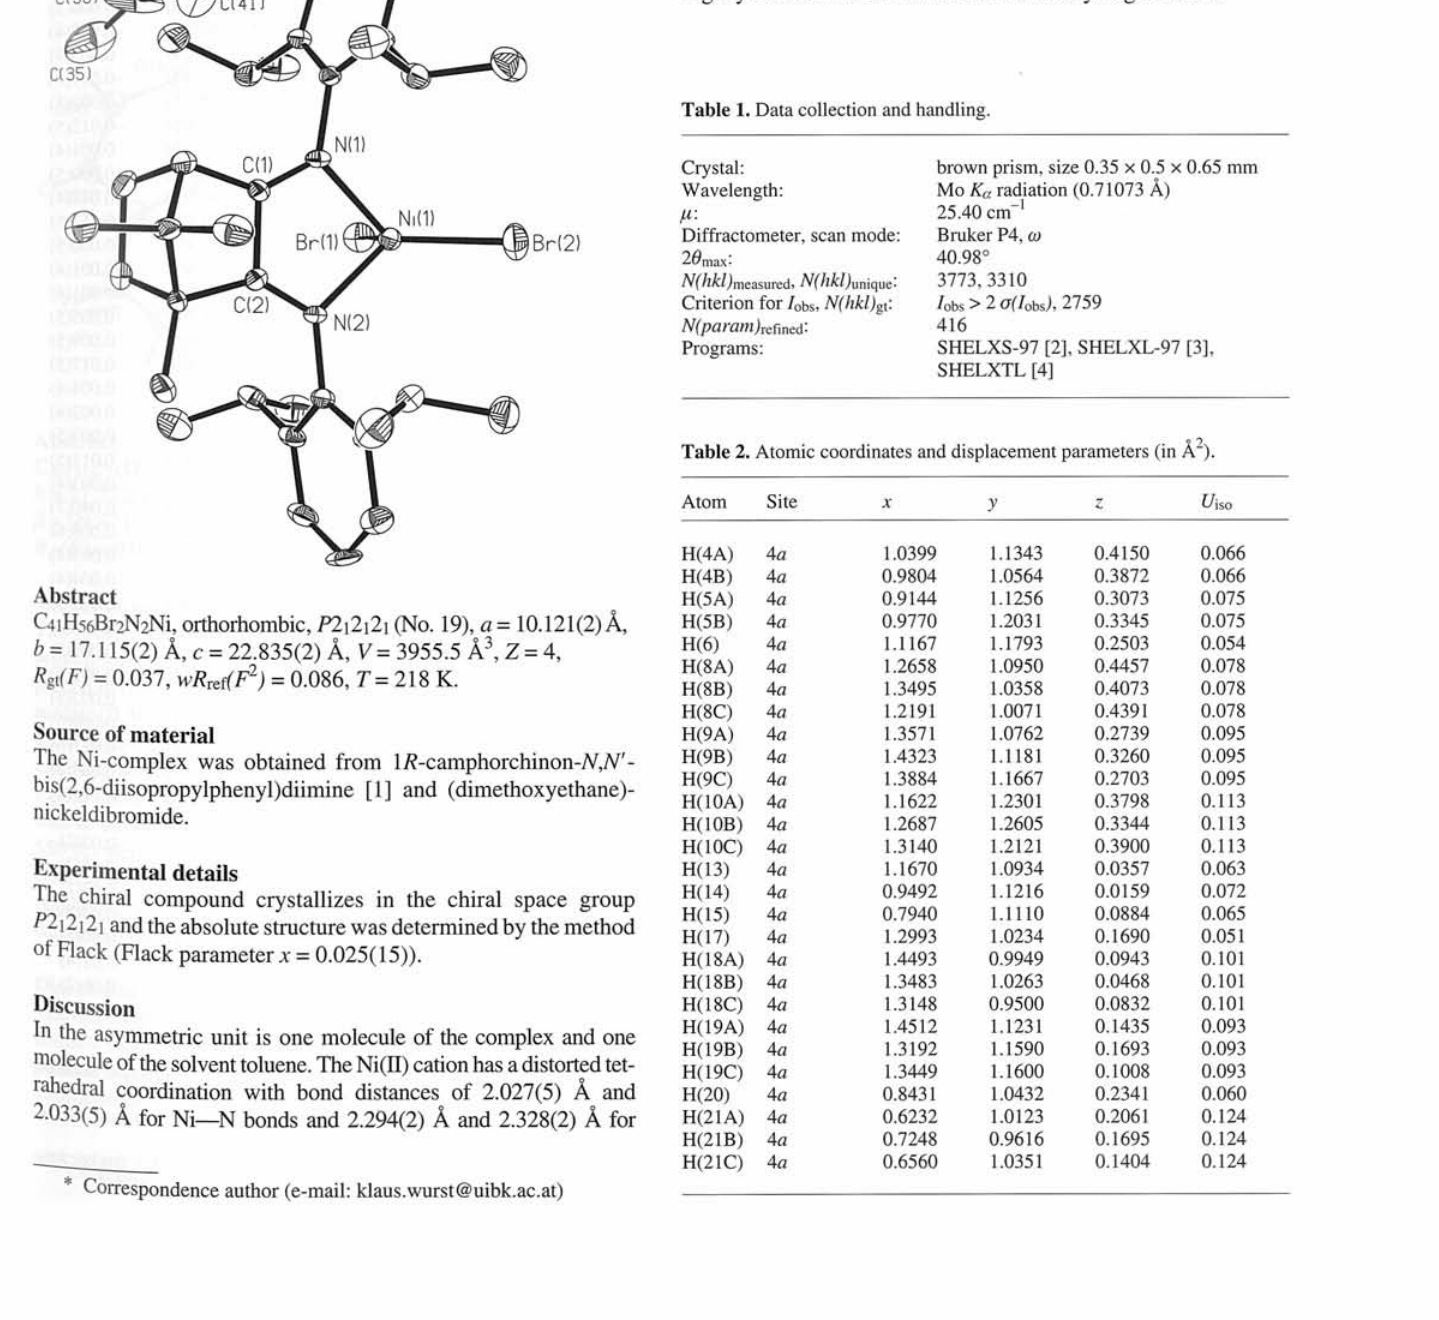
Ni—Br bonds. The smallest and greatest bond angle is ¿N1-NÍ2-N2 with 82.8(2)° and ZBrl-Nil-Br2 with 123.5(1)°. The double bonds of the imino groups are located between Nl-Cl and N2-C2 with bond distances of 1.272(8) Á and 1.274(8) Â. The solvent toluene is slightly disordered and was refined without hydrogen atoms.